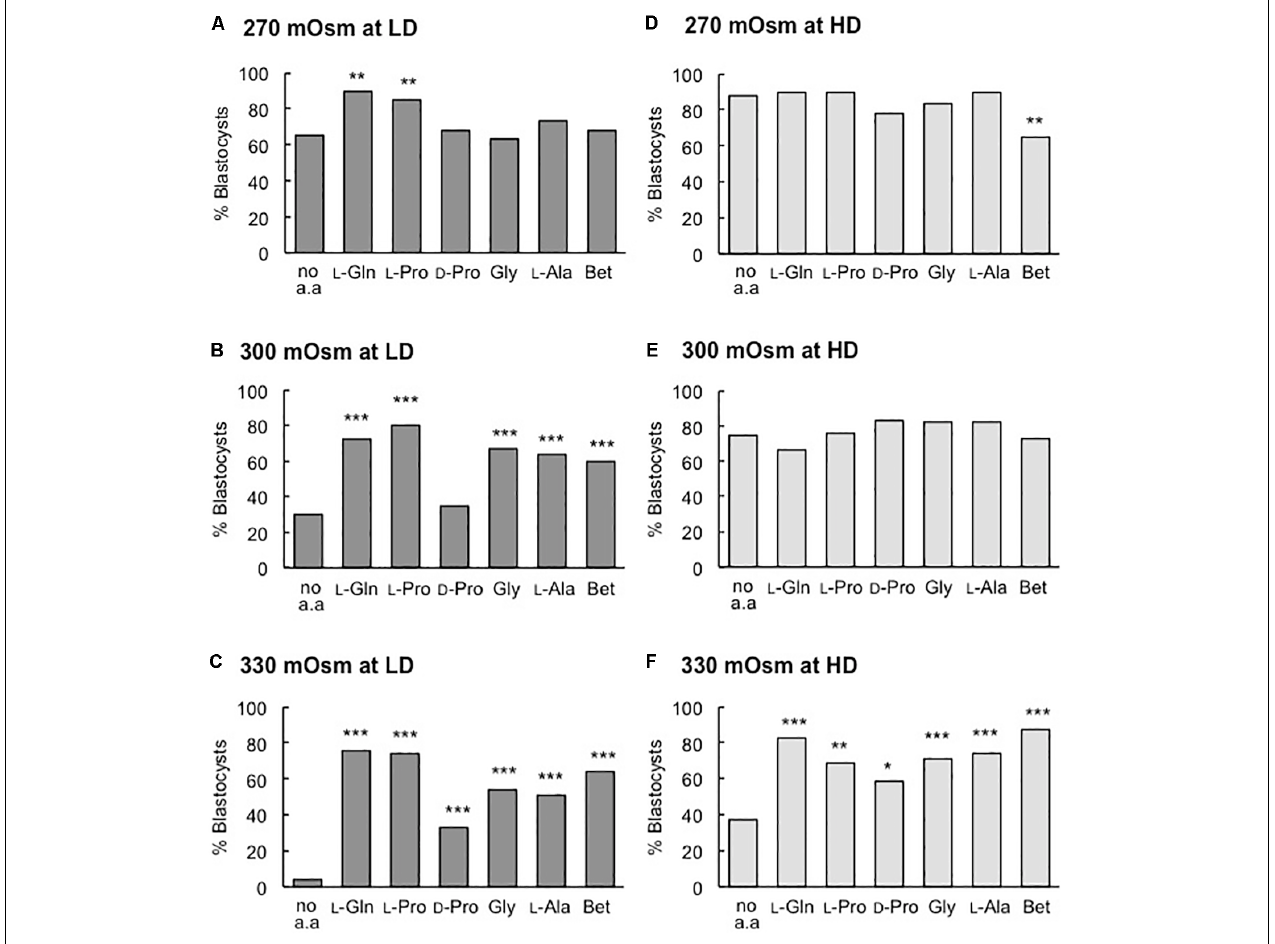
FIGURE 3 | Effect of individual amino acids on blastocyst development in media of different osmolality at LD (A–C) and HD (D–F) . Zygotes (20–22 h post-hCG) were cultured for 5 days in the absence of amino acids (no a.a.) or in the presence of 1 mM L-Gln, 400 µ M L-Pro, 400 µ M D-Pro, 400 µ M Gly, 400 µ M L-Ala or 1 mM Betaine (Bet) in medium with an osmolality of (A,D) 270 mOsm/kg, (B,E) 300 mOsm/kg and (C,F) 330 mOsm/kg. Embryos were analyzed from at least three independent biological replicates, each with at least 15 embryos per treatment. * P < 0.05; ** P < 0.01; *** P < 0.001 indicates significant differences from the no amino acid control, analyzed by Chi-squared